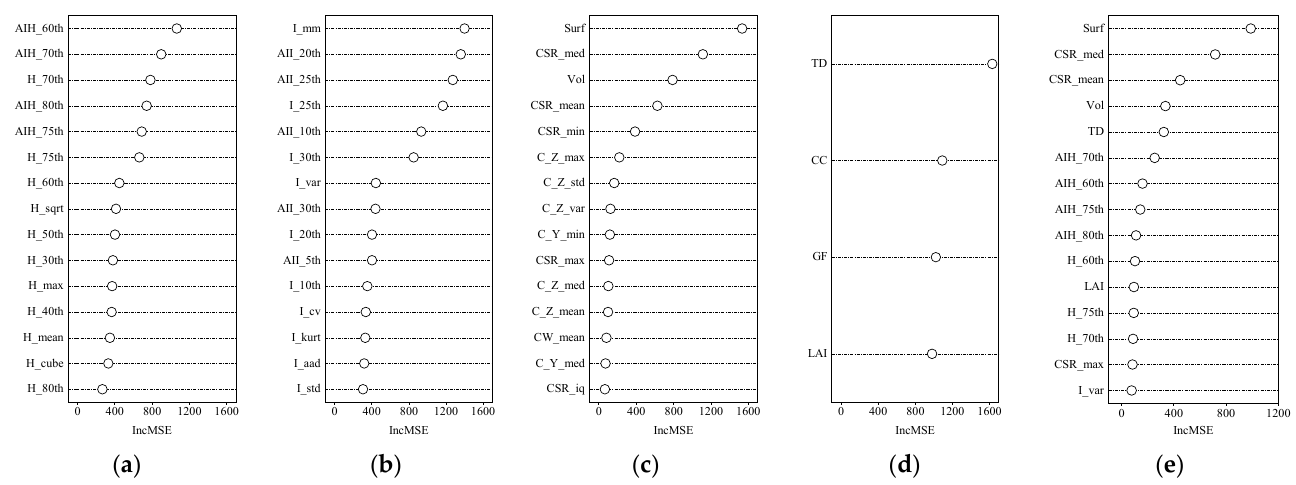
Figure 3. Feature importance rankings of top 15 in height, intensity, and alpha-shape metrics, respectively, and feature importance ranking of stand metrics. ( a ) Height metrics, ( b ) Intensity metrics, ( c ) Alpha-shape metrics, ( d ) Stand metrics, ( e ) All variables.